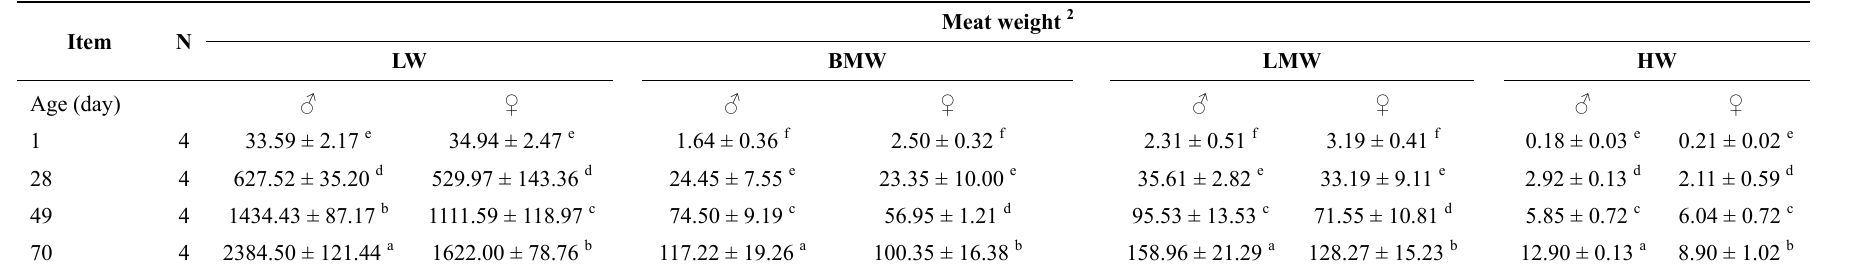
Table 2. The meat weights by age and sex 1